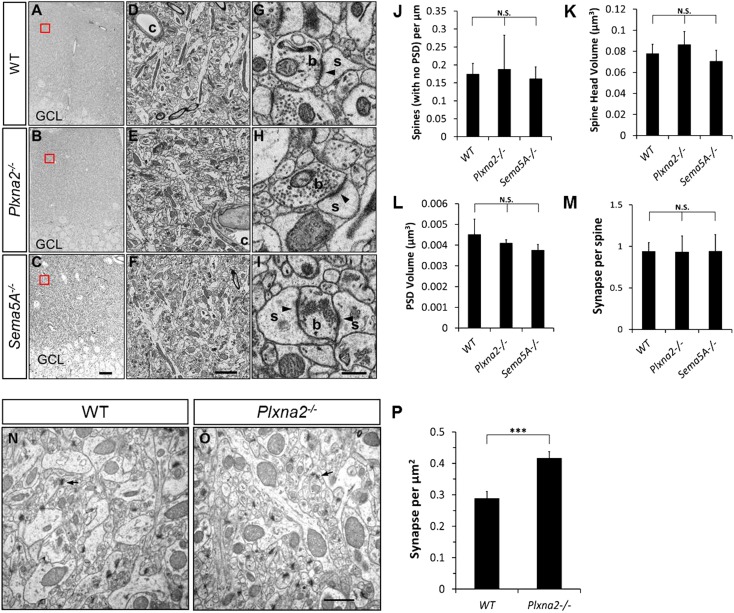
Ultra-structural analysis of the Plxna2−/− and Sema5A−/− dentate gyrus molecular layer (ML).The rostral DG of P32 mice was subjected to serial block-face scanning electron microscopy (sEM). (A, D and G) Coronal sections show part of the granule cell layer (GCL) and the entire width of the ML of the hippocampus of WT (A), Plxna2−/− (D) and Sema5A−/− mice (G). The area boxed in red is shown at higher magnification in panels B and C for WT mice, panels E and F for Plxna2−/− mice, and panels H and I for Sema5A−/− mice. (B, C, E, F, H and I) Examples of higher magnification images of dentate ML, c = capillary. Examples of spine synapses composed of a dendritic spine (s) with a large head, a post-synaptic density (PSD, arrowhead) and a presynaptic bouton (b) with neurotransmitter vesicles. For 3D reconstruction, dendritic segments (each 20–22 µm in length) and their spines were traced in individual sEM images. (J) The number of dendritic protrusions that do not show a PSD is very similar among the three genotypes: WT (0.17 ± 0.03 spines/µm), Plxna2−/− (0.19 ± 0.09 spines/µm) and Sema5A−/− (0.16 ± 0.03 spines/µm) mice. (K) Quantification of spine head volume of WT (0.08 ± 0.01 µm3), Plxna2−/− (0.09 ± 0.01 µm3), and Sema5A−/− (0.07 ± 0.01 µm3) GCs did not reveal a significant difference. (L) Quantification of the surface area of the PSD revealed no significant differences between WT (0.06 ± 0.009 µm2), Plxna2−/− (0.06 ± 0.003 µm2), and Sema5A−/− (0.05 ± 0.003 µm2) mice. (M) The number of presynaptic boutons that contact a dendritic spine (i.e., synapses formed per spine) is not significantly different between WT, Plxna2−/− and Sema5A−/− GCs. (N and O) Two-dimensional EM images of P30 littermate Plxna2+/+ (WT, n = 2) and Plxna2−/− (n = 2) mice (arrow points to PSD). (P) Quantification of synapse density in 2D EM images. Scale bars in A, D, G = 20 µm; in B, E, H = 2 µm, in C, F, I = 0.2 µm, in N, O = 0.8 µm. For quantification of 3D EM images, n = 110, 208, and 165 spines were analyzed for WT (n = 1), Plxna2−/− (n = 1) and Sema5A−/− (n = 1) mice, respectively. Values are represented as mean ± SEM from three to four dendritic segments for each genotype. ***p < 0.001, N.S. = not significant (p > 0.05) two-tailed unpaired Student's t test.